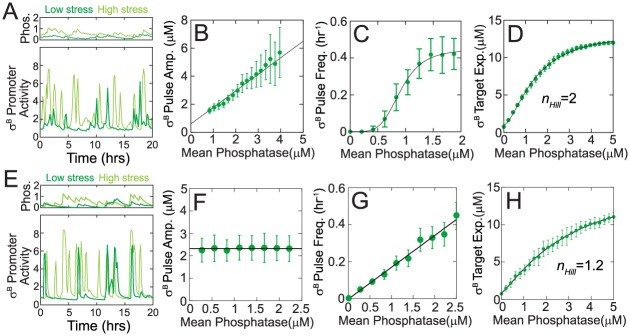
Pulsatile response of the σB network to stochastic phosphatase bursts during energy stress.Model simulations for σB network response where energy stress leads to an increase in stress-sensing phosphatase RsbQP burst size (A-D) or RsbQP burst frequency (E-H). A,E. Simulations show stochastic bursts in levels of RsbQP lead to pulses of σB target promoter activity. Light and dark green curves are sample trajectory from stochastic simulation at high and low stress respectively. Note that σB target promoter activity pulse amplitude increases significantly with increasing stress for burst size modulation (A) but not for burst frequency modulation (E). B,F. Mean σB pulse amplitude increases linearly as a function of mean phosphatase level for burst size modulation (B) but is insensitive to mean phosphatase level for burst frequency modulation (F). Green circles and errorbars show means and standard deviations calculated from stochastic simulations. Black line is a linear fit. C,G. With increasing mean phosphatase level, mean σB pulse frequency increases ultrasensitively for burst size modulation (C) and linearly for burst frequency modulation (G). Green circles and errorbars show means and standard deviations calculated from stochastic simulations. Black curves are a Hill-equation fit with nHill = 5.6 in (C) and a linear fit in (G) respectively. D,H. Mean σB target expression increases ultrasensitively as a function of mean phosphatase level for both burst size (D) and burst frequency (H) modulation. Green circles are the mean σB target expression calculated from stochastic simulations. Black curve is a Hill-equation fit with nHill = 2 in (D) and in nHill = 1.2 (H).